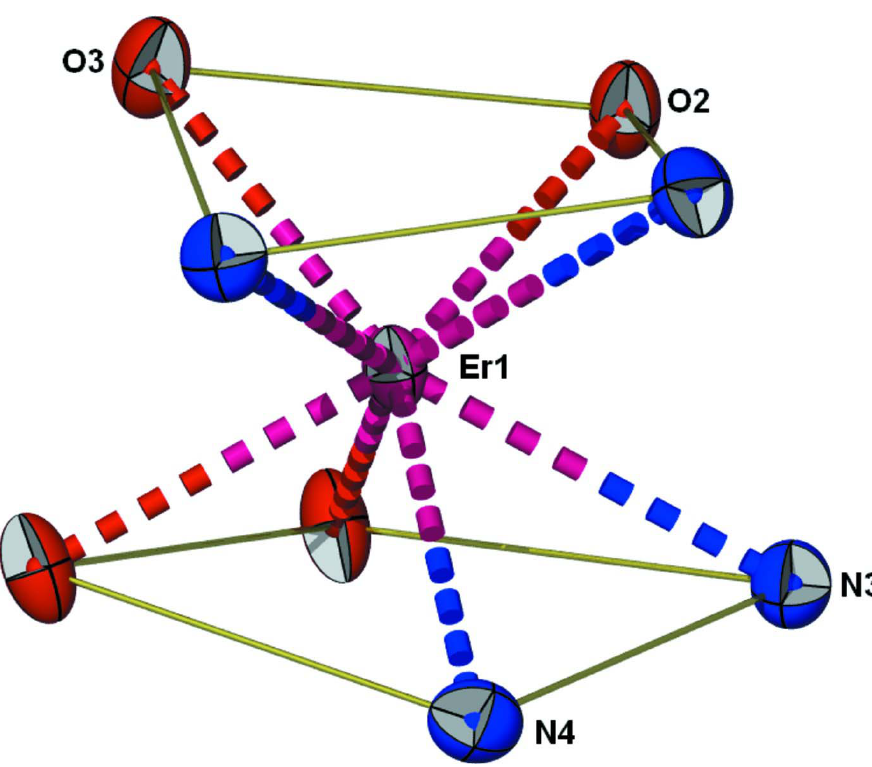
Figure 2 Square antiprismatic coordination geometry of Er. (6-Oxido-2-oxo-1,2-dihydropyrimidine-5-carboxylato- κ 2 O 5 , O 6